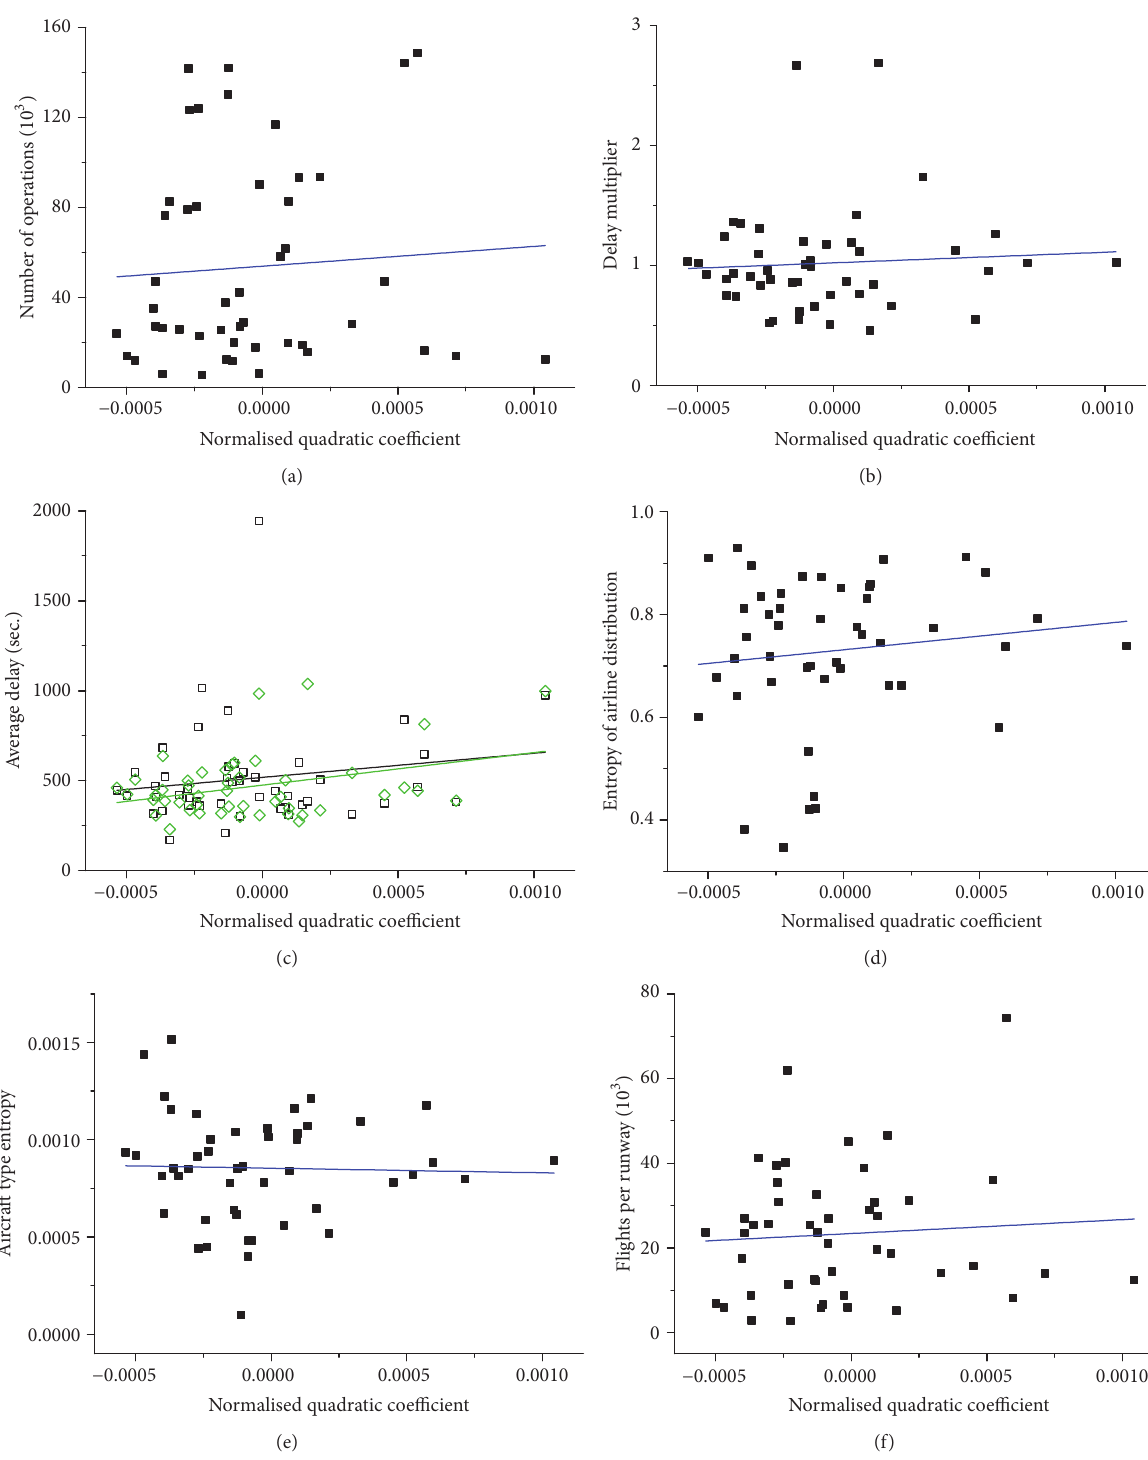
Figure 5: Normalised quadratic coefficient and airport properties. From (a) to (f), the six panels, respectively, depict the correlation between the coefficient and the size of the airport (number of operations); the airport standard delay multiplier; the average inbound (black squares) and outbound (green diamonds) delay; the entropy of the airline distribution; the entropy of the aircraft type distribution; and the number of flights per runway; see main text for